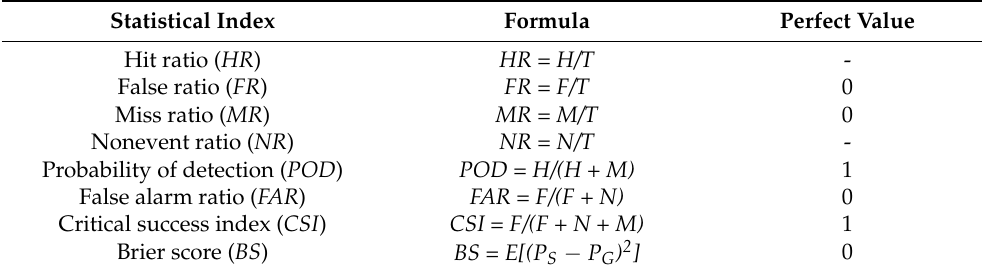
Table 2. The statistical metrics used to evaluate the detection capacity of